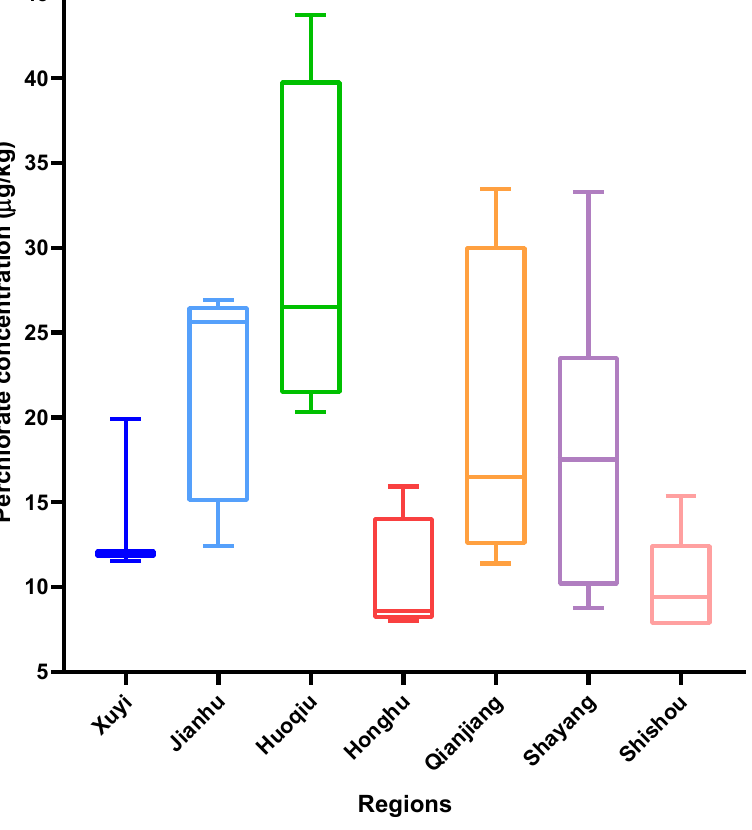
Figure 2. Occurrence of perchlorate in cultivated crayfish among different regions.